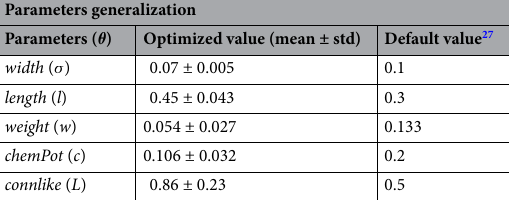
Table 1. Standard parameters for global tracking obtained by multi-objective optimization and MCDA over multiple marmoset